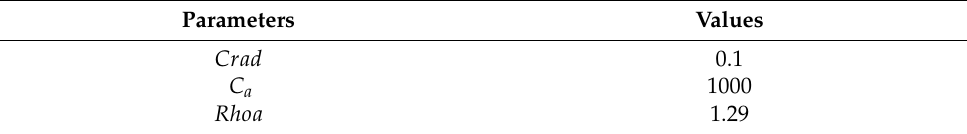
Table 1. Parameters adopted in the literature